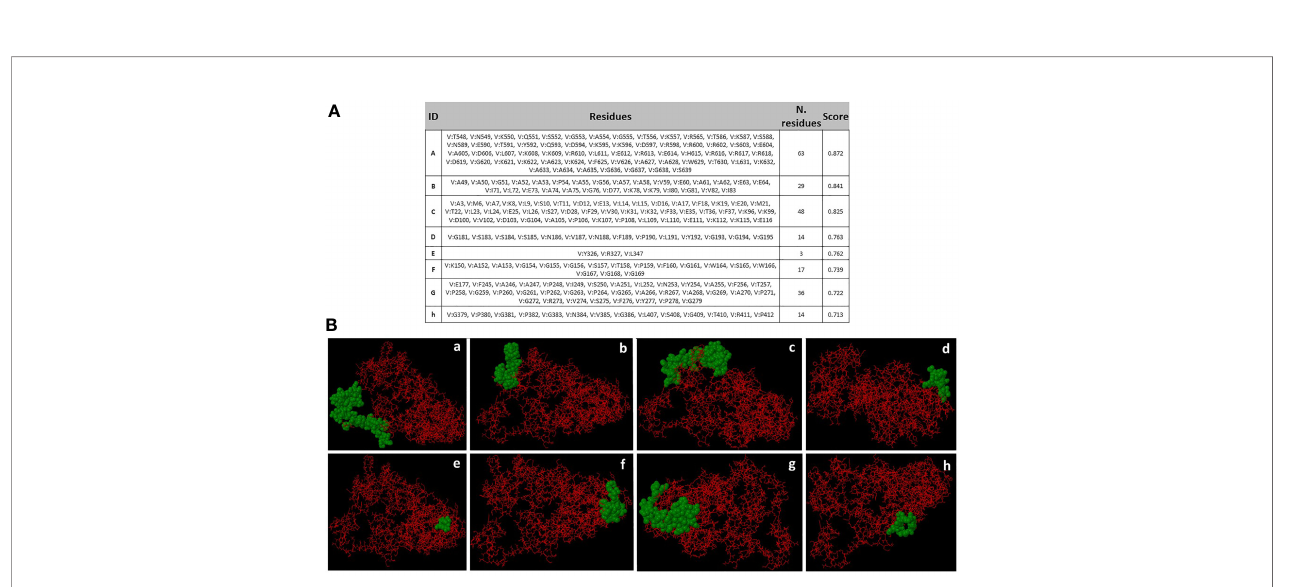
FIGURE 7 | Conformational B-cell epitopes prediction. (A) Amino acid residues present in conformational epitopes, the number of residues and their scores. ID: Identi fi cation of Epitopes. (B) a-h : 3D representation of conformational B-cell epitopes of protein. The predicted epitope residues are represented by green color, and the bulk of the polyprotein is represented in red